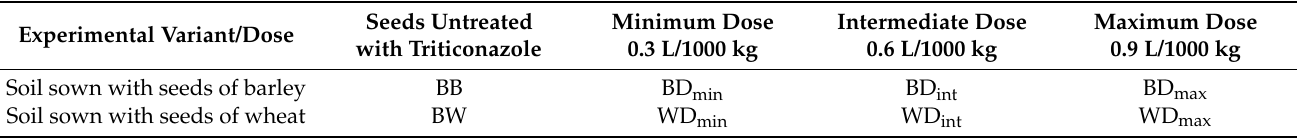
Table 1. Experimental variants considered in this